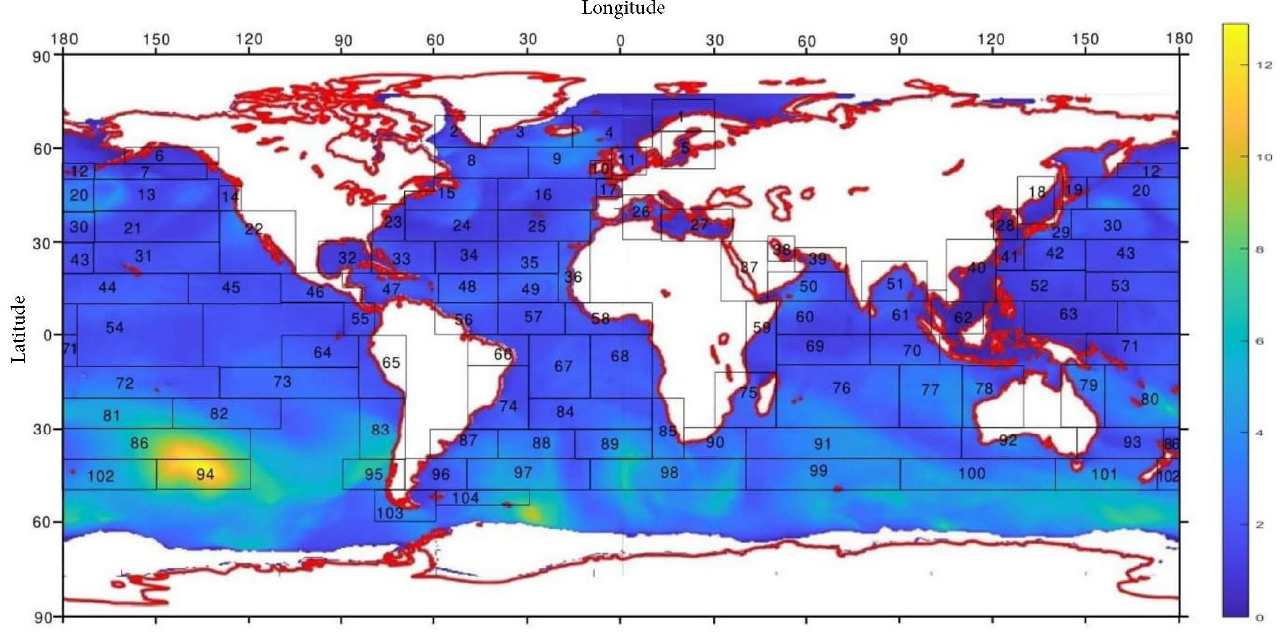
Figure 2. Sea area nomenclature with hindcast significant wave height snapshot.